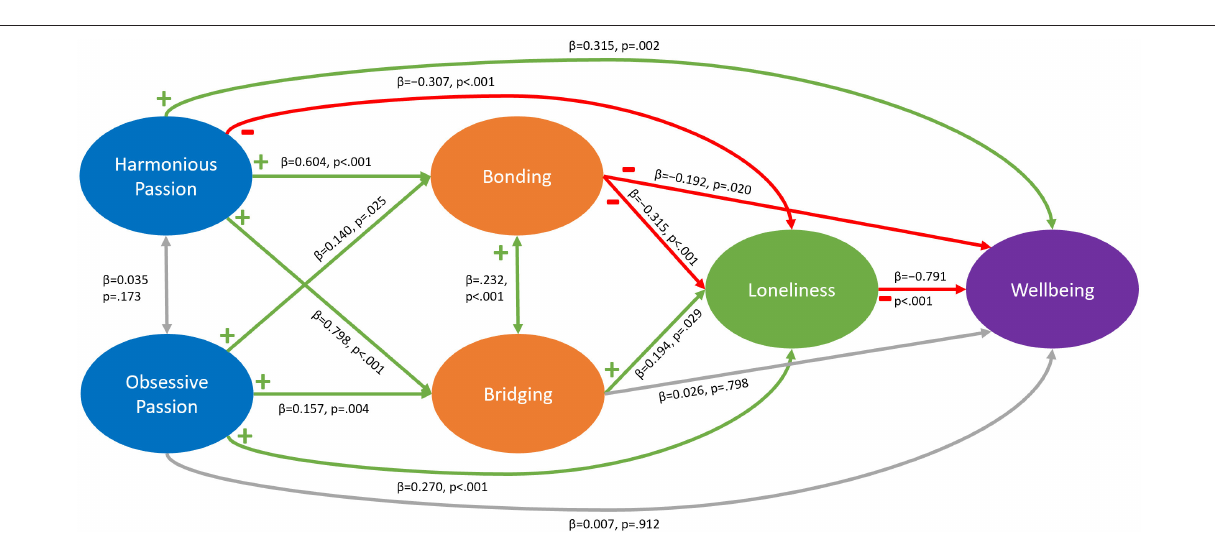
FIGURE 3 | Direct effects for hypothesized paths. β denotes unstandardized